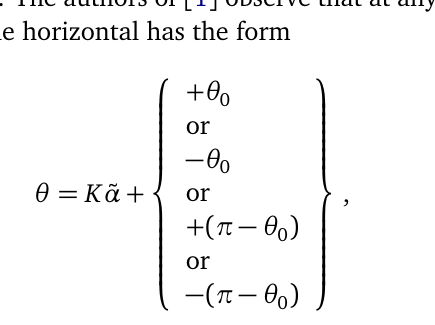
Figure 1: The right-triangular billiards considered in [ 1 ] . θ of the initial velocity. ˜ α/ 2 is one of the angles. See text for the rationale behind the names of the sides of the